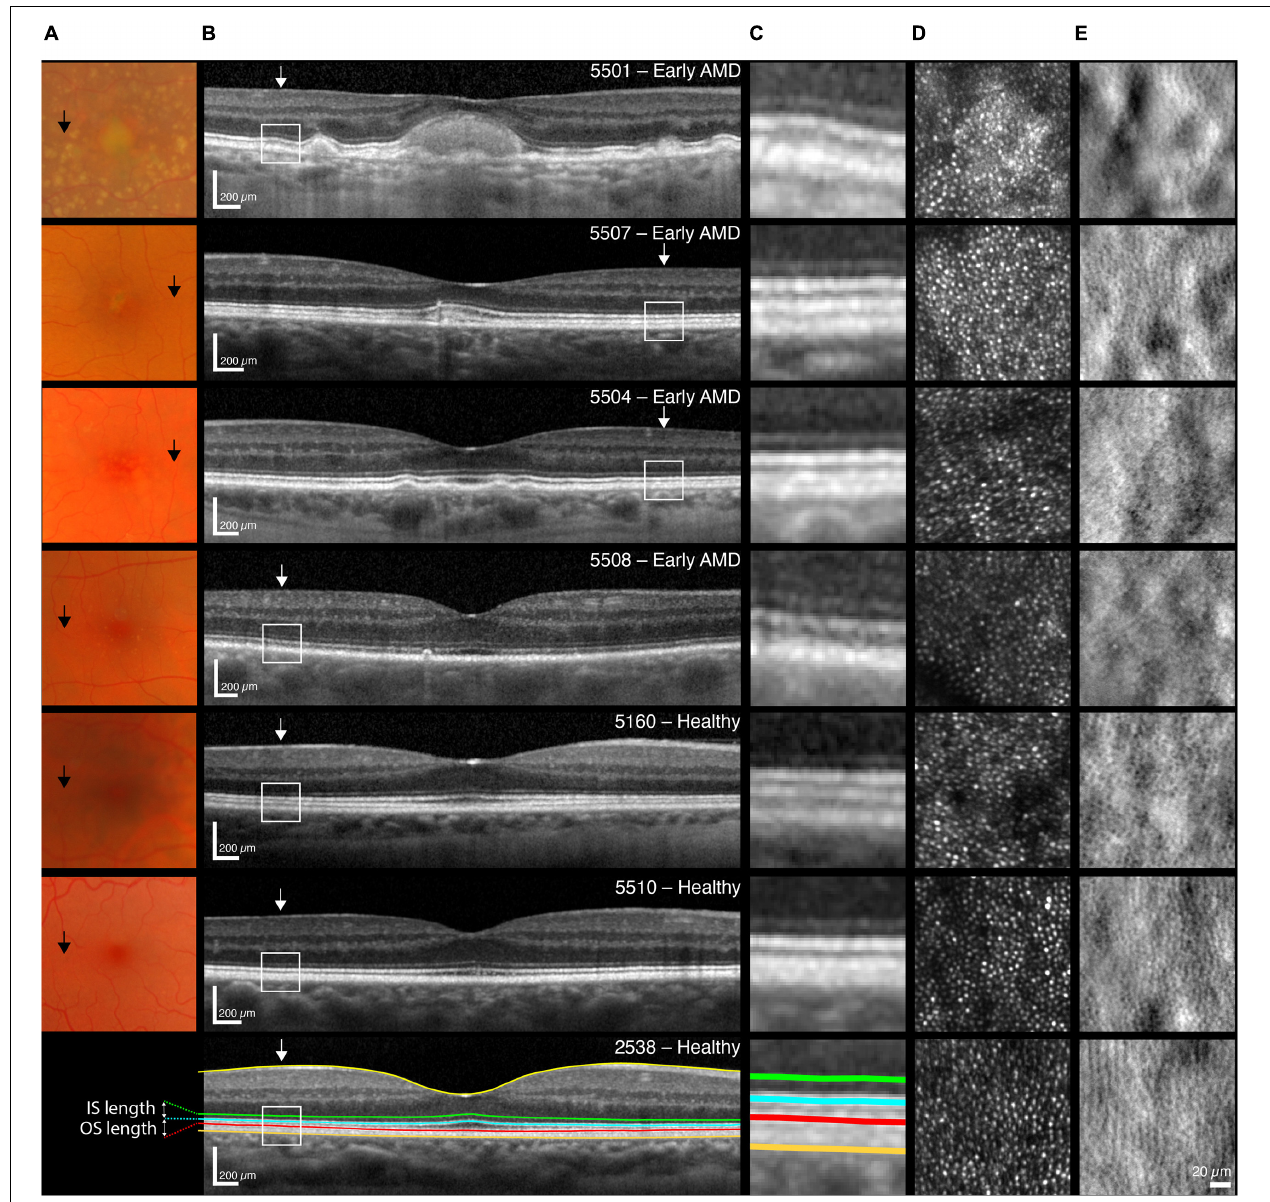
FIGURE 1 | Multimodal images of one participant with early AMD and high-risk of progression (5501, top row), followed by one with medium risk (5507) and two with low-risk (5504, 5508); as well as three normal controls [5160 (68 years), 5510 (65 years), 2538 (35 years)]. (A) Color fundus photos of the central 14 degree of the macula. Black arrows indicate 5 degree temporal eccentricity. (B) Horizontal SD-OCT scan through the foveal center of the central ± 7 degree including an illustration of the segmented inner limiting membrane (ILM, yellow line), the external limiting membrane (ELM, green line), the inner/outer segment junction also referred to as the inner segment ellipsoid zone (EZ, blue line), the cone outer segment tips also referred to as the interdigitation zone (IZ, red line) and the retinal pigment epithelium—Bruch’s membrane layer (RPE-BrM, orange line). The inner segment (distance from ELM to EZ) and outer segment (distance from EZ to IZ) lengths were extracted and used for analyses. White arrows indicate 5 degree temporal eccentricity. Scale bars = 200 µ m. (C) A magnification of a one-degree area centered at 5 degree eccentricity, delineated by white boxes in B. Images from 5501 had visible drusen in this area and showed marked thickening in the RPE layer. None of the other participants with early AMD showed any apparent retinal changes within this area. (D) Raw confocal and (E) split-detection images showing reflection from cone outer segments and multiple-scatter image of cone inner segments at 5 degree eccentricity (temporal). Images are 150 × 150 µ m or approximately 0.52 × 0.52 degree, scale bar = 20 µ